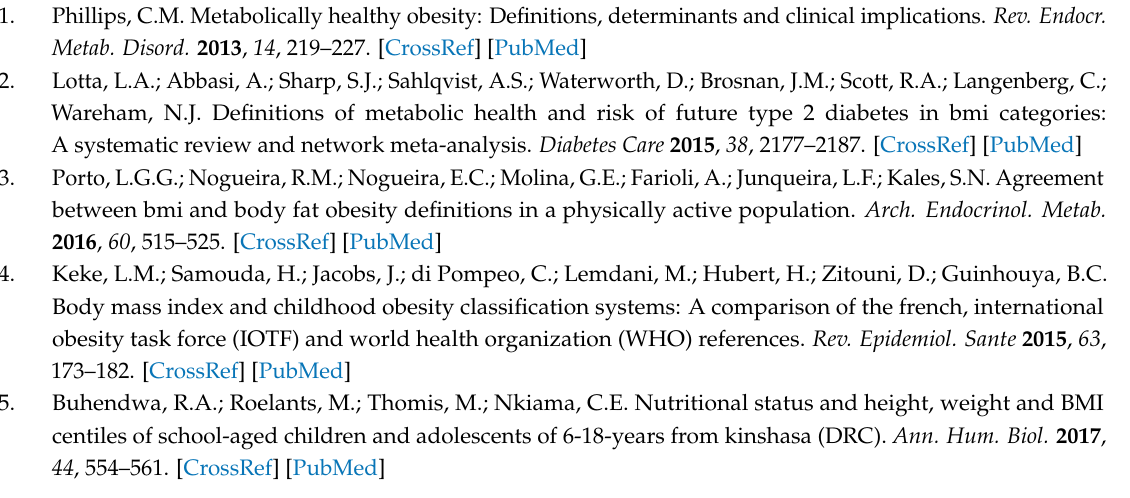
Table S1: Disease genes of 22 OMIM disease classes and their Ensembl IDs, Table S2: Gene symbols of 379 obesity genes and their Ensembl IDs, Table S3: Maximum interaction scores and p -value for each disease gene of 22 disease classes, Table S4: The tissues/organs where genes related to “Endocrine”, “Psychiatric” and “Bone” were significantly